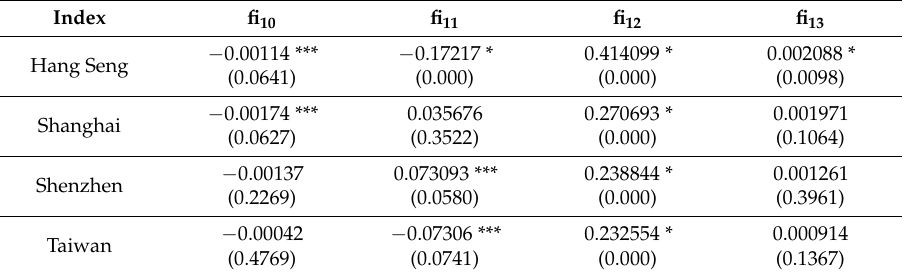
Table 4. Market Model 01.